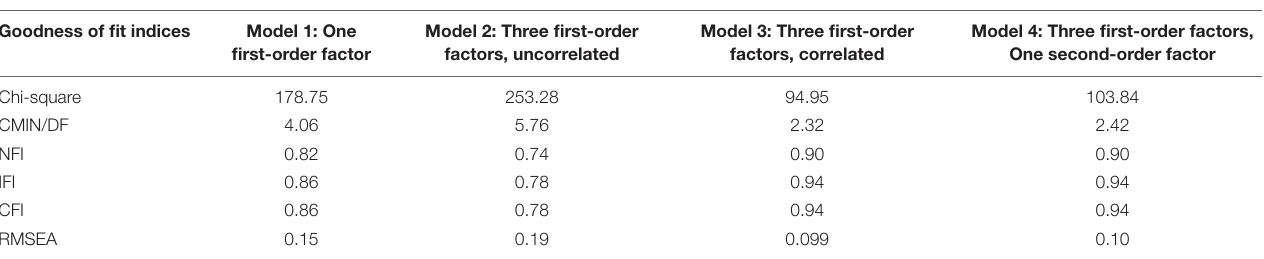
FIGURE 1 | Theoretical higher-order structural model including moderating effect. TABLE 4 | Alternative measure